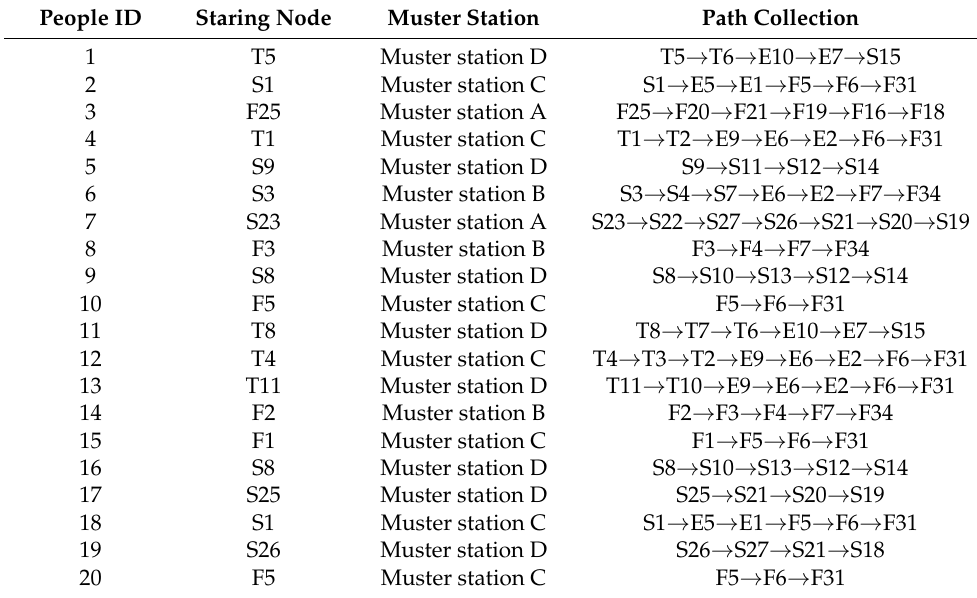
Table 5. Evacuation routes of part of the